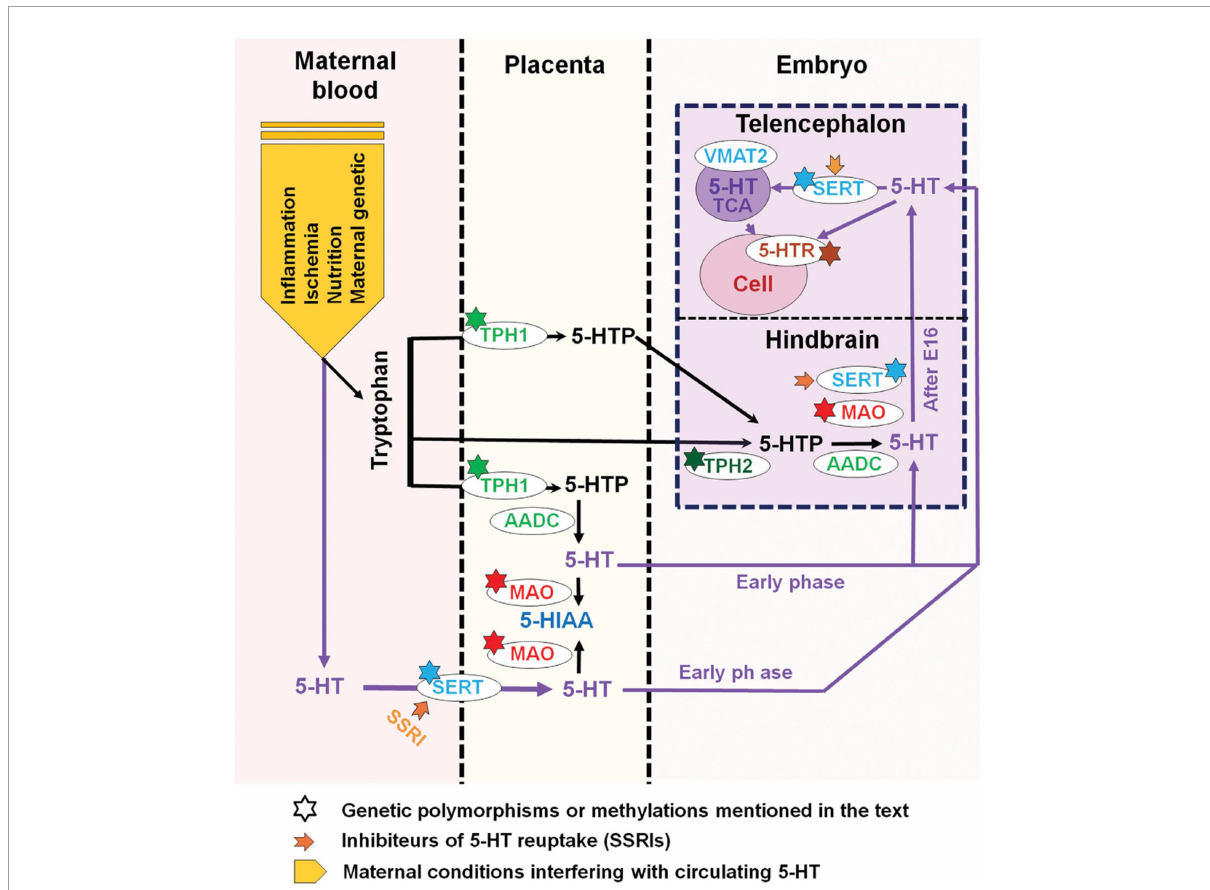
FIGURE7 Maternal, placental, genetic, and pharmacological conditions determining the amount of serotonin supply to the developing telencephalon. The placenta provides tryptophan to the embryo but can also convert it into 5-HTP (5-hydroxytryptamine) or further into serotonin (5-HT) via various maternal metabolic enzymes. In addition, 5-HT from maternal sources could be taken up by the placenta where the serotonin transporter (SERT) is also expressed. During early embryonic stages, 5-HT could thus be directly delivered to the developing embryo. In the mouse, after E15-E16 (approximately GW 16 in humans), when 5-HT axons of the hindbrain reach the cortex, 5-HT could act on various target cells expressing selected arrays of 5-HT receptors. At this stage, 5-HT could also be taken up and stored by thalamocortical afferents (TC) and released after specific stimulation. In addition, 5-HTP is provided by Tph2 (tryptophan hydroxylase type 2) and AADC (aromatic amino acid decarboxylase) containing neurons that synthetize 5-HT. The large downward arrow on the left in this diagram, adapted from Bonnin and Levitt (2011), points to the maternal conditions that are best known to interfere with 5-HT availability to the embryo. Inhibitors of 5-HT uptake (SSRIs) which affect SERT function at all levels are indicated by a thick orange arrow while known genetic polymorphisms or epigenetic alterations (methylations) which impact serotonin supply are indicated by a star. The major catabolic enzymes of 5-HT are MAO (monoamine oxidases) and tryptophan hydroxylase type 1 (Tph1). Adapted from Bonnin and Levitt (2011) and Vitalis and Verney (2017), obtained by Elsevier (No. 5410821023270) under a creative commons license